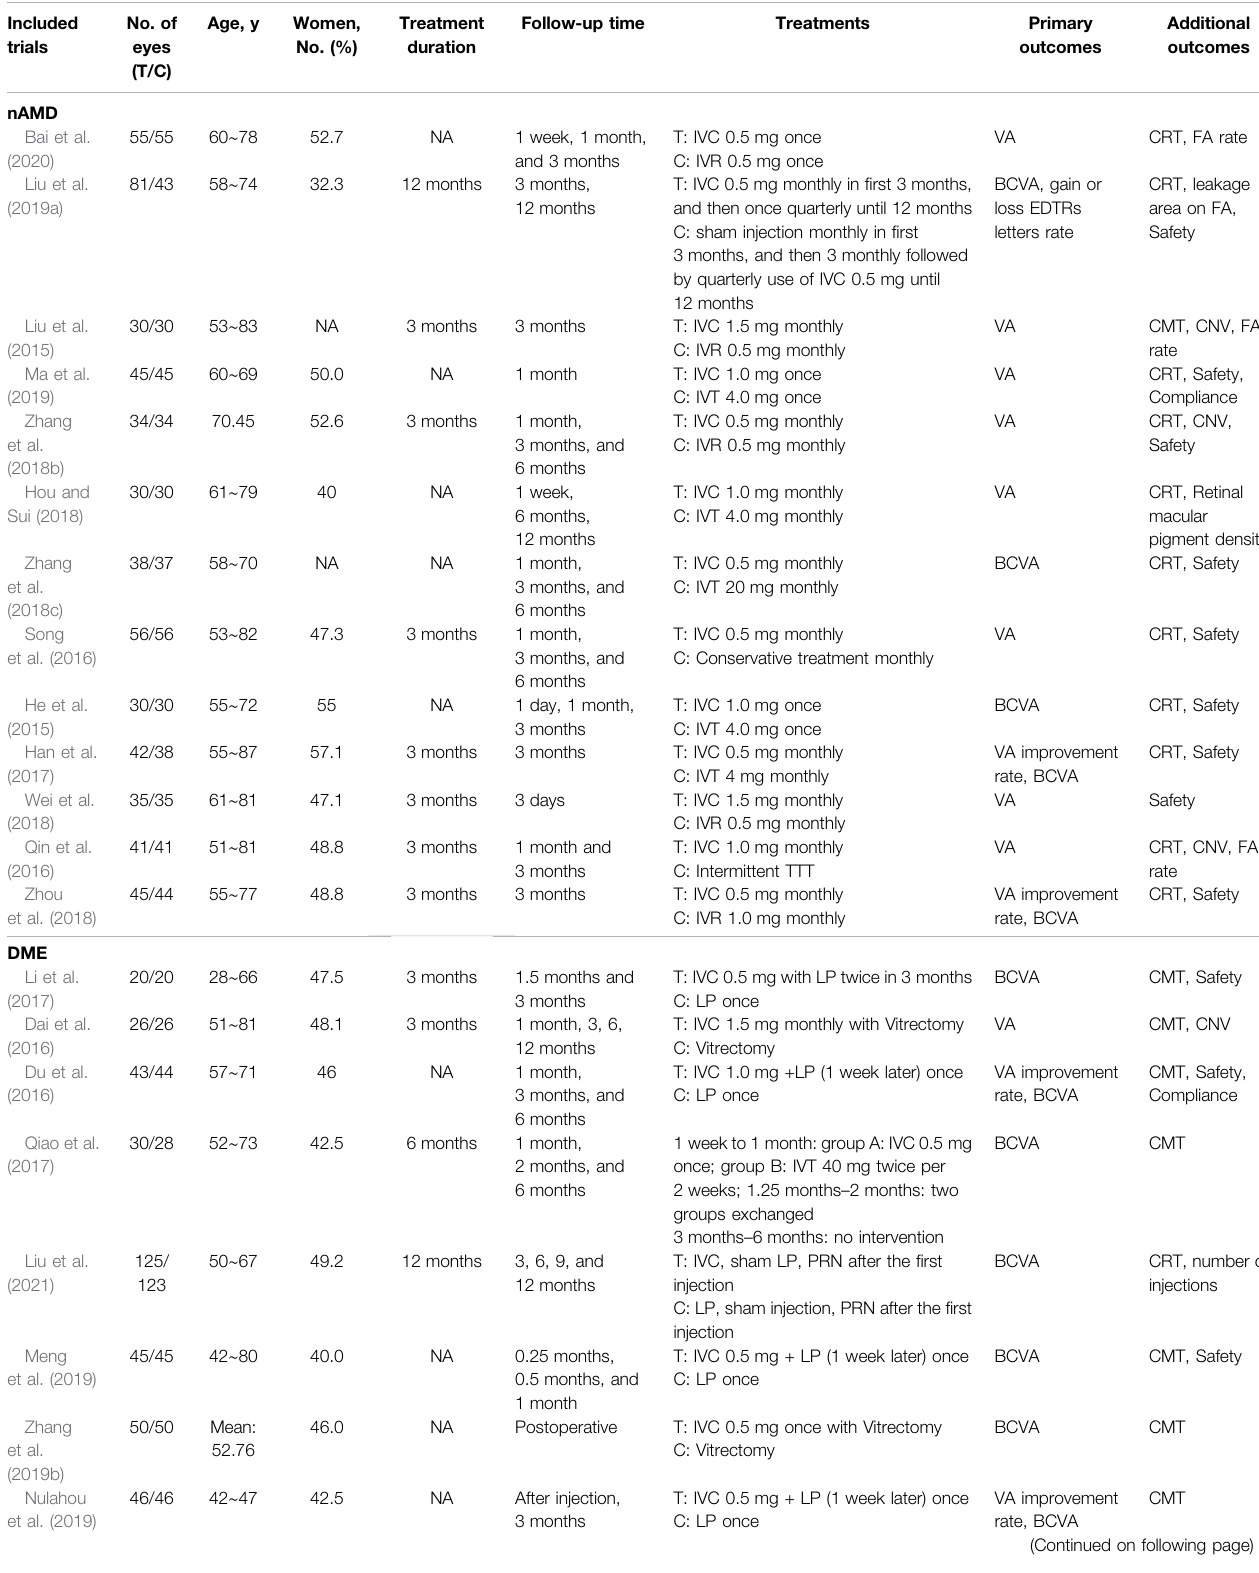
TABLE 1 | Characteristics of the included trials and participants. Included trials